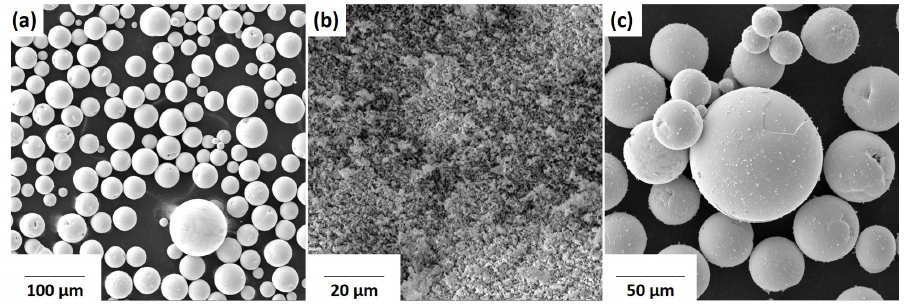
Figure 1. ( a ) Spherical pure molybdenum powder. ( b ) Nanosized silicon carbide. ( c ) Mixed Mo-0.1SiC powder.